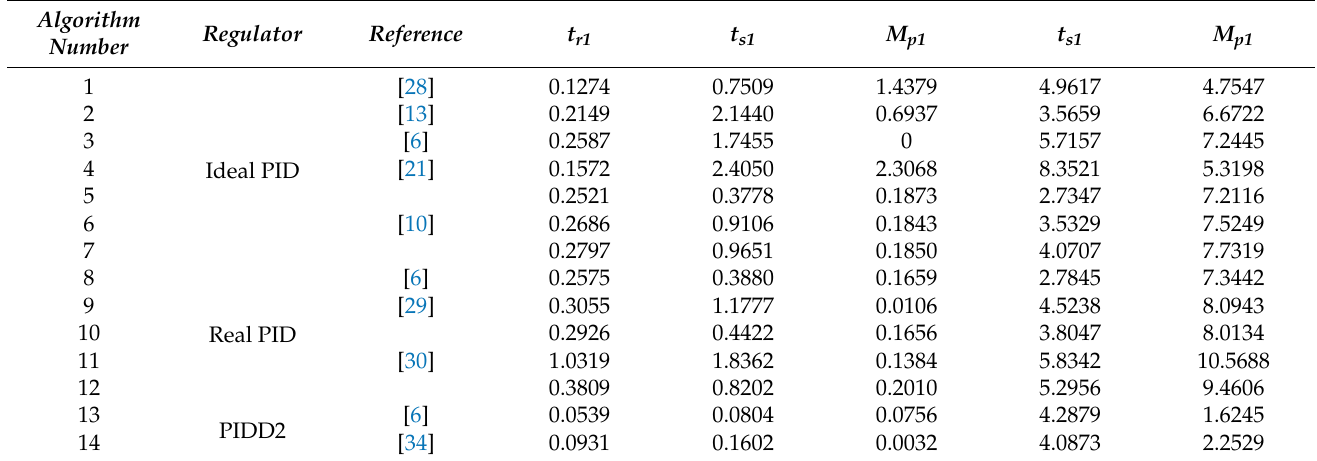
Table 6. Comparison of the transient response provided using the regulator parameters given in Table